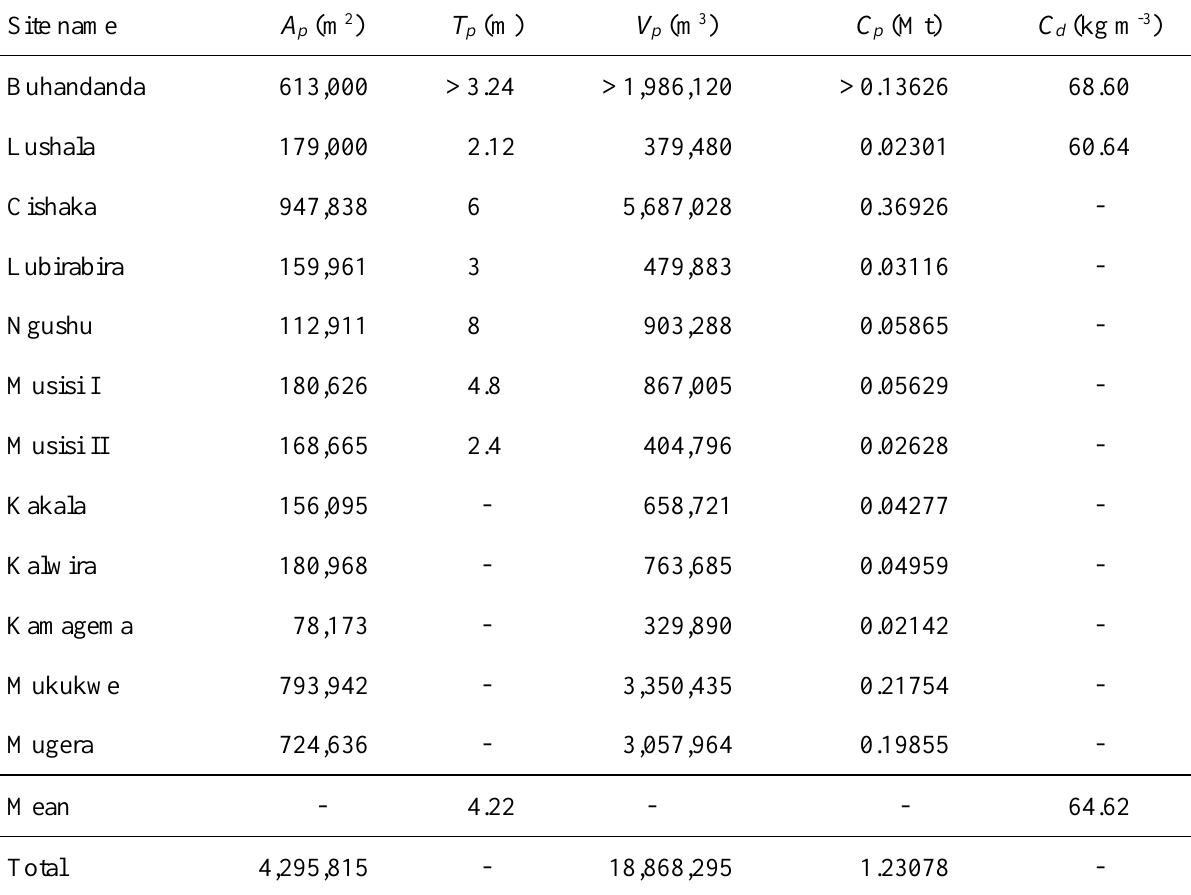
Table A2. Estimates of carbon stocks for the 12 main peatlands in Sud-Kivu Province (see Figure 1). A = area of peatland; T = mean peat thickness from Kabony (2012) except for Buhandanda and Lushala (this p p study); V = volume of peat (Equation 4); C = carbon stock (Equation 5). Missing data are indicated by ‘-‘. p p Carbon density ( C = BD × C ) is known for Buhandanda and Lushula only. In all cases of missing data, the d c calculations were performed using mean values calculated from available data ( T C = 0.3888 g g -1 (38.88 c